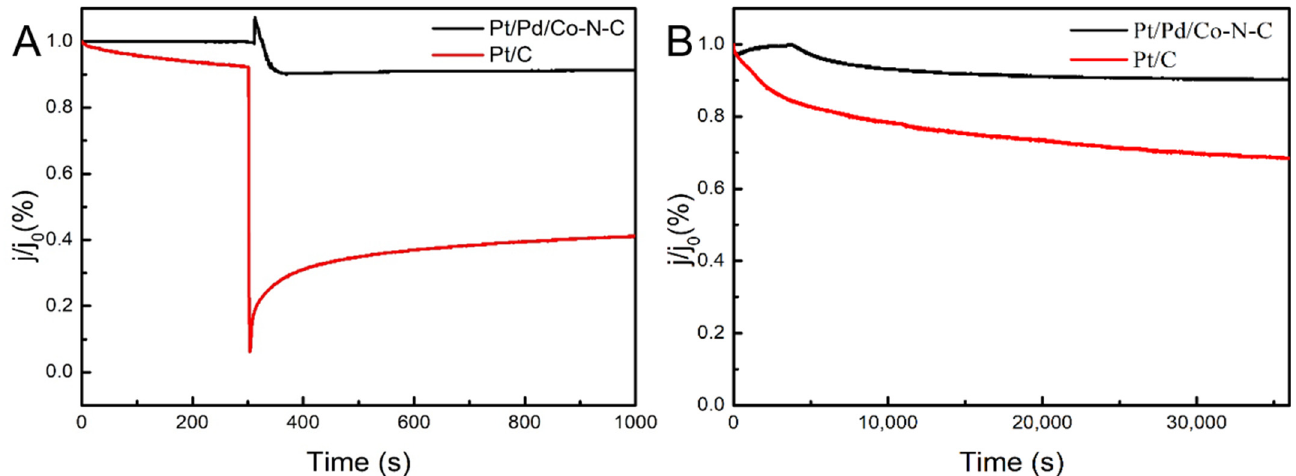
Figure 5. Chronoamperometric responses to the addition of 1 M methanol for Pt/Pd/Co-N-C and Pt/C ( A ); Chronoamperometric responses of Pt/Pd/Co-N-C and Pt/C with a rotating speed of 1600 rpm in O 2 -saturated 0.1 M KOH ( B ).